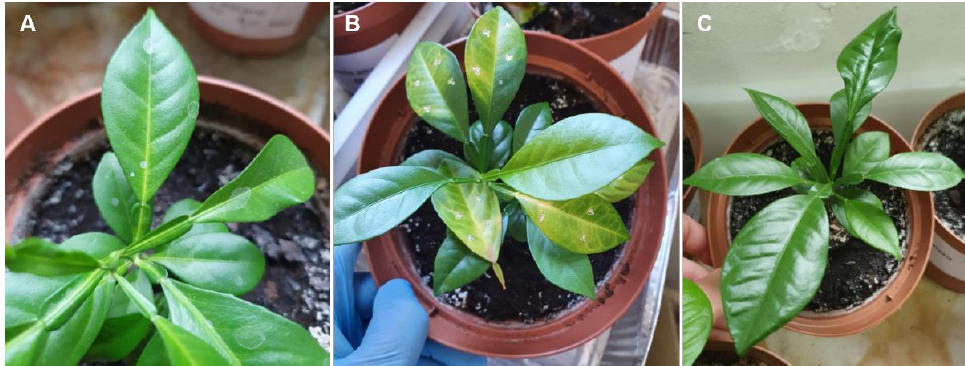
Figure 1. Symptoms developed upon Plenodomus tracheiphilus inoculation in roots ( A ) and leaves ( B ) of sour orange seedlings six and two months post-inoculation, respectively, and non-inoculated control ( C ).